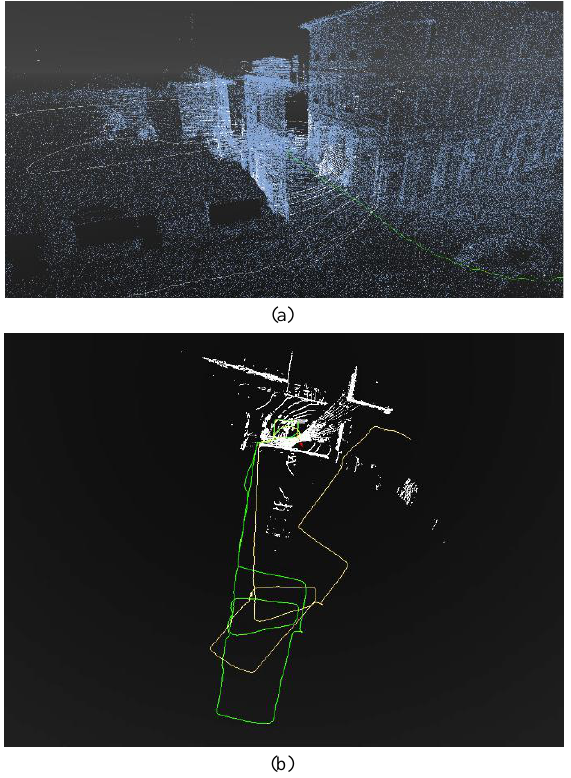
Figure 4. (a) Trajectory reconstruction during the Odometer phase; (b) Planimetric view of the overlap between the imported raw trajectory (yellow) and the same trajectory after the Odometer phase